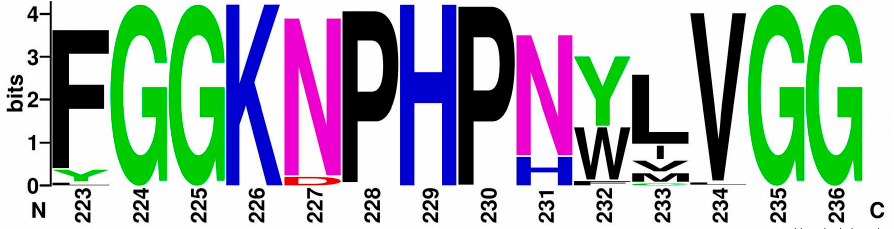
Figure 5. Sequence logo of large subunit consensus for hydrogenases from HydDB database (215 sequences, residues from 223 to 236). Hydrophobic residues are shown in black, amides are shown in magenta, other hydrophilic neutral residues are shown in green, negatively charged residues are shown in red, and positively charged residues are shown in blue. Ordinate shows information content of the alignment positions in bits (log 2 20 = 4.321928 if the residue is absolutely conserved).